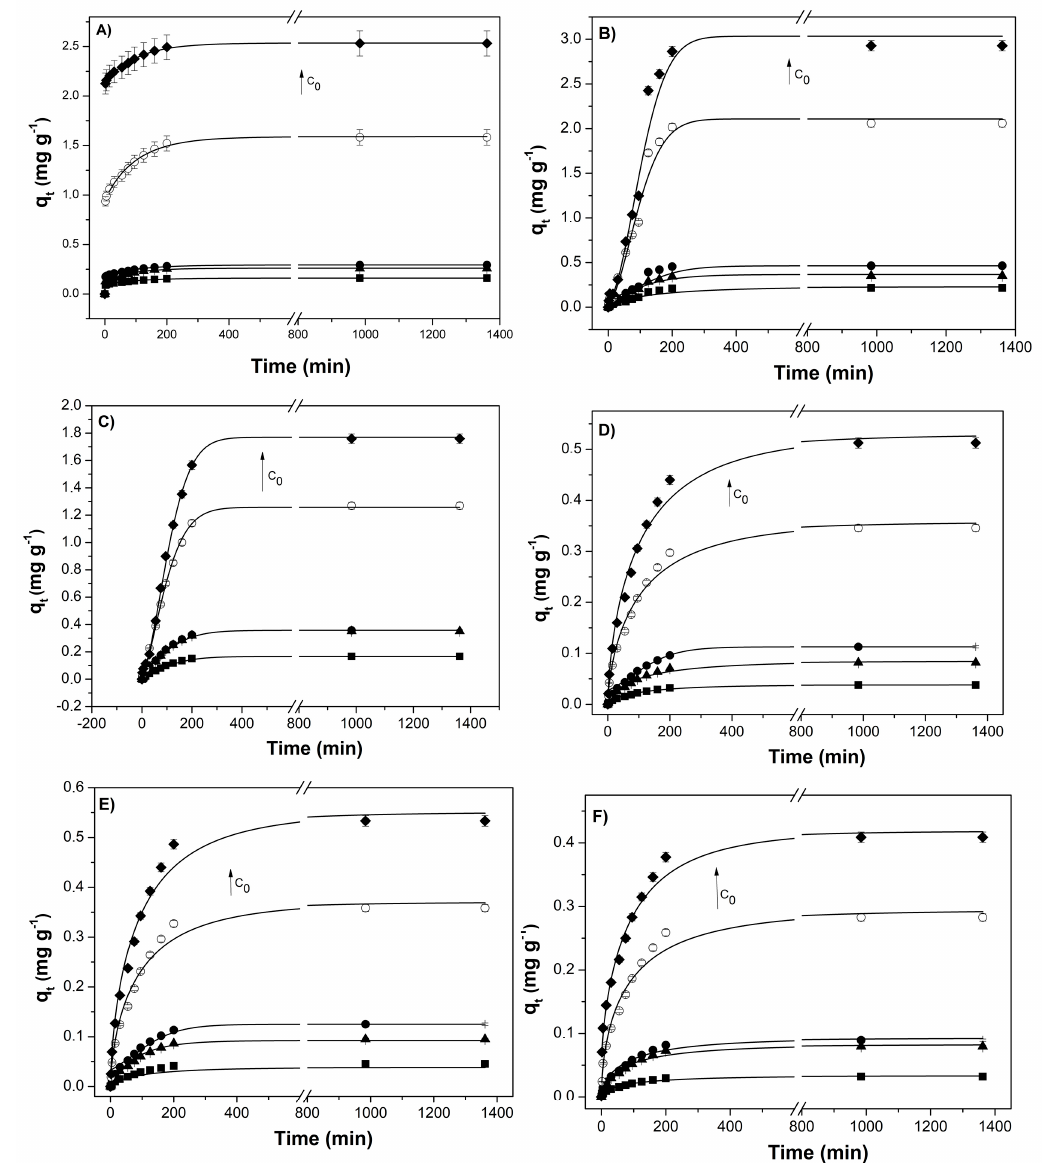
Figure 7. Sorption kinetic of mono-and polycyclic aromatic hydrocarbons, in mixed solutions (benzene ( A ), toluene ( B ), xylene ( C ), pyrene ( D ), B(b)F ( E ), and B(a)P ( F )), at 25 °C, onto the PVA/CS/MA- β -CD hydrogel (intermediate swelling degree), and for several hydrocarbons C 0 values (the arrow indicates the direction of higher concentrations).